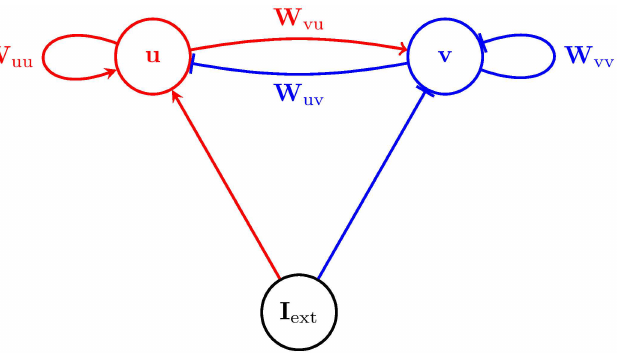
Fig 3. The architecture of the Hamiltonian network. The network consists of two populationsof neurons, excitatory neurons with membrane potential u , and inhibitoryneurons v , driven by external input I input . Neuronsin the network are recurrentlycoupledby synapticweights, W uu , W uv , W vu and W vv . Red arrows representexcitation; blue bars represent